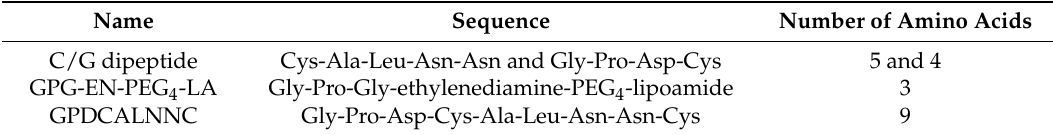
Table 1. Peptide sequences trialed to enhance gold nanoparticle (Au NP) stability.